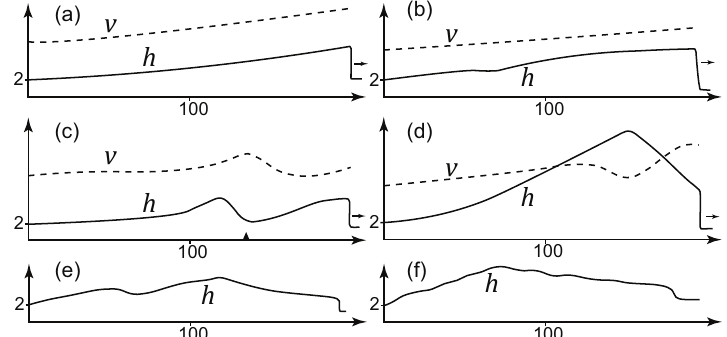
Figure 2. An avalanche in a chute. Calculated distributions of the depth (full lines) and velocity (dashed lines) along the avalanche body: ( a ) wide chute, ( b ) narrow chute; ( c ) the avalanche passes the sharp increase in the chute width; location of the change in the chute width is indicated by a small black triangle; ( d ) the avalanche after the pass of the decrease in chute width; ( e , f ) the shapes of the avalanche